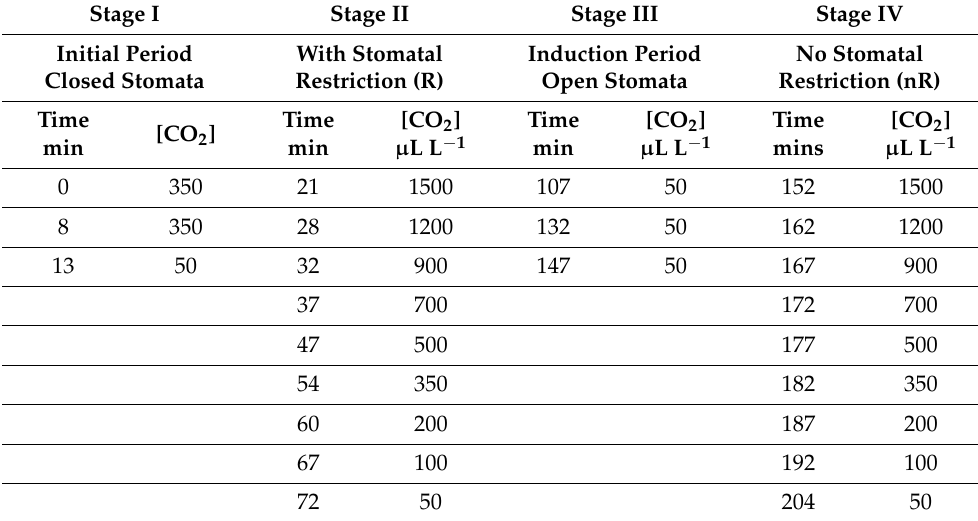
Table 1. Times of application of different concentrations of environmental CO 2 to induce the closure and opening of